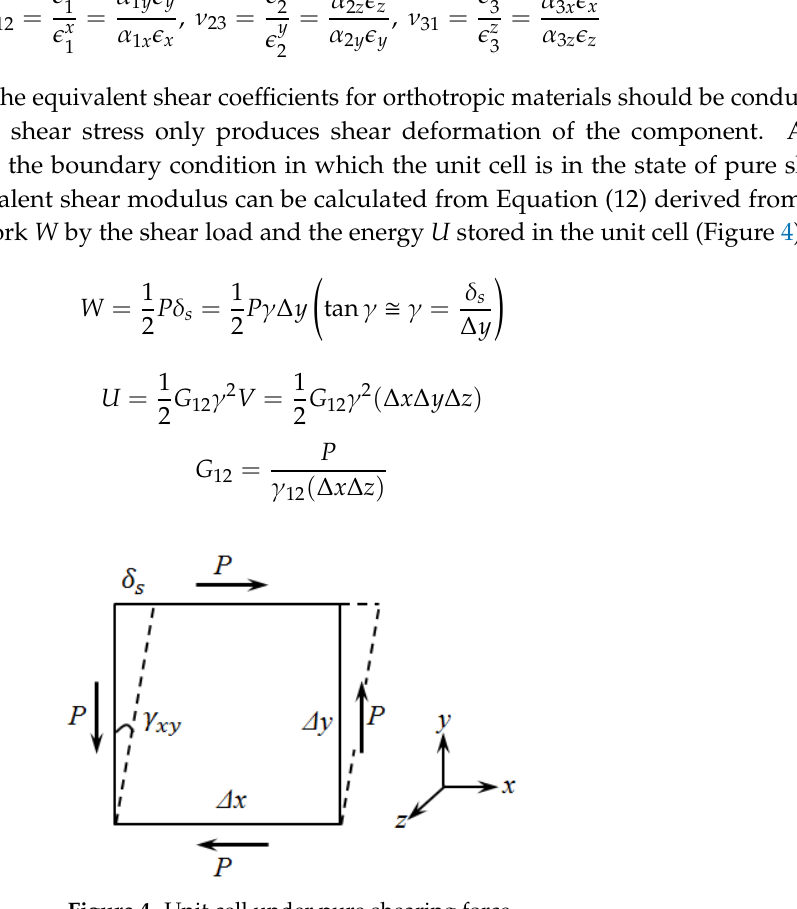
Figure 4. Unit cell under pure shearing force.